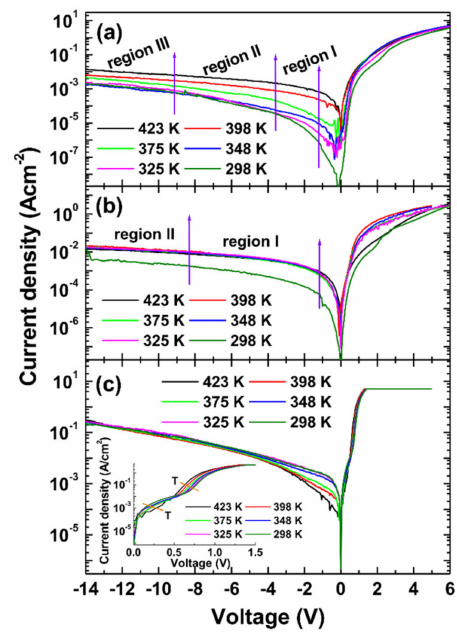
Figure 2. Semilogarithmic current–voltage ( I – V ) data obtained at di ff erent temperatures for samples ( a ) A, ( b ) B, and ( c ) C. The inset in ( c ) shows the I – V curves for narrow forward bias range obtained from sample